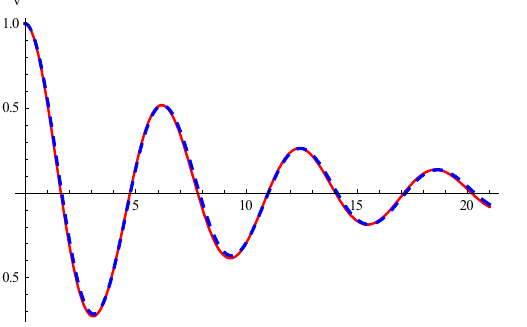
Figure 5. Comparison between the numerical solution of Equations (11) and (23) at internal resonance and approximate solution (61) : ____ numerical integration solution; _ _ _ analytical solution..